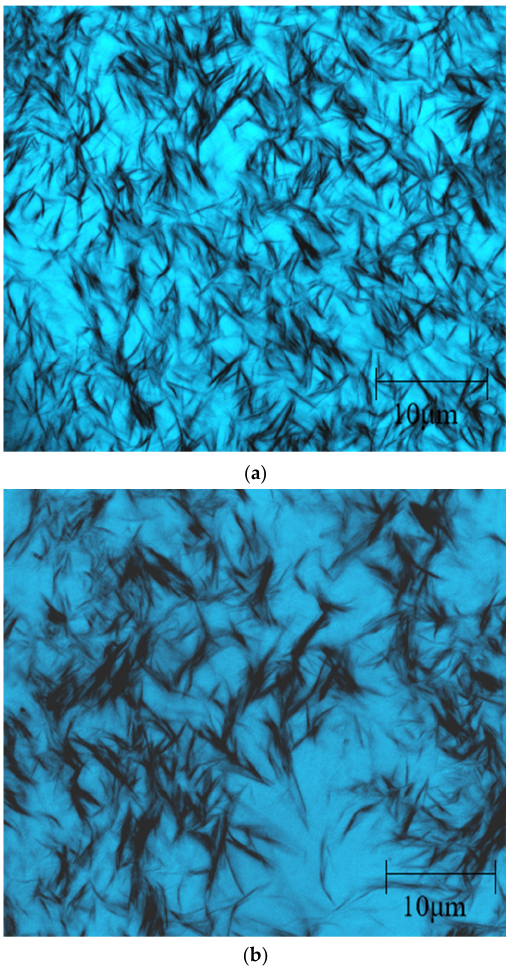
Figure 4. Photography of paraffin crystal in saturated HC of the heavy oil before ( a ) and after ( b ) aquathermolysis. ( b )